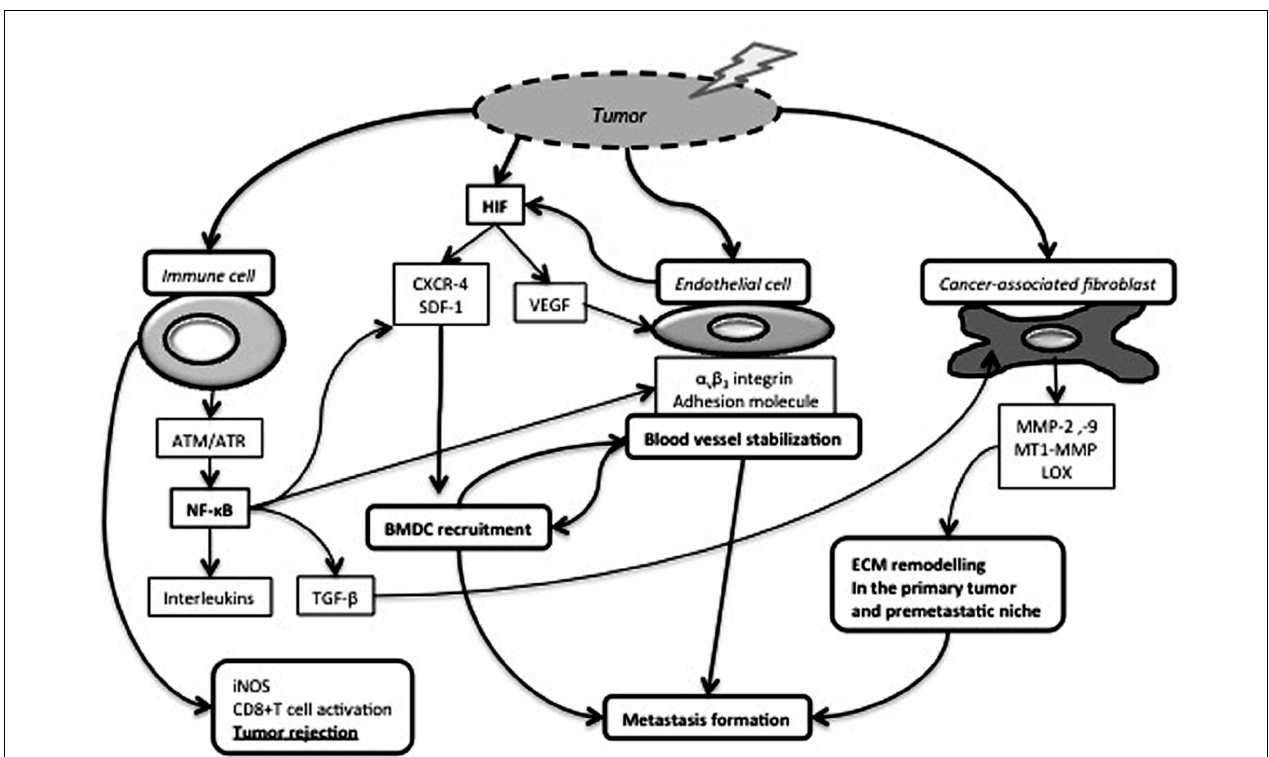
FIGURE 2 | Impact of RT on cancer-associated immune cells, endothelial cells and fibroblasts. Tumor irradiation leads to the production and stabilization of HIF-1, which induces Vascular Endothelial Growth Factor (VEGF) production and subsequently endothelial cell proliferation and survival. Endothelial cells increase their membrane expression of α v β 3 integrins and adhesion molecules. Those modifications in cell adhesion molecule expression and HIF-1-dependent CXCR-4/SDF-1 release contribute to Bone Marrow Derived Cell (BMDC) recruitment favoring in turn blood vessel stabilization and metastasis formation. RT also activates cancer-associated fibroblasts (CAF) and induces the release of extracellular matrix) (ECM) remodeling enzymes facilitating cell invasion and metastasis formation. NF- κ B pathway is activated in irradiated immune cells and regulates the release of numerous cytokines, including TGF- β , an epithelial-to-mesenchymal transition inducer and a CAF activator. On the other hand, induction of inducible Nitric Oxide Synthase (iNOS) expression by tumor-associated macrophages participates to cytotoxic T cell activation and tumor